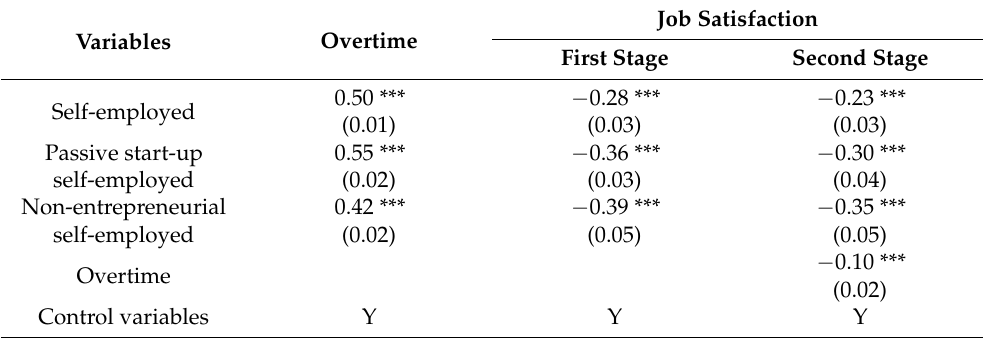
Table 7. OLS and logit regression results of self-employment’s impact on job satisfaction mediated by